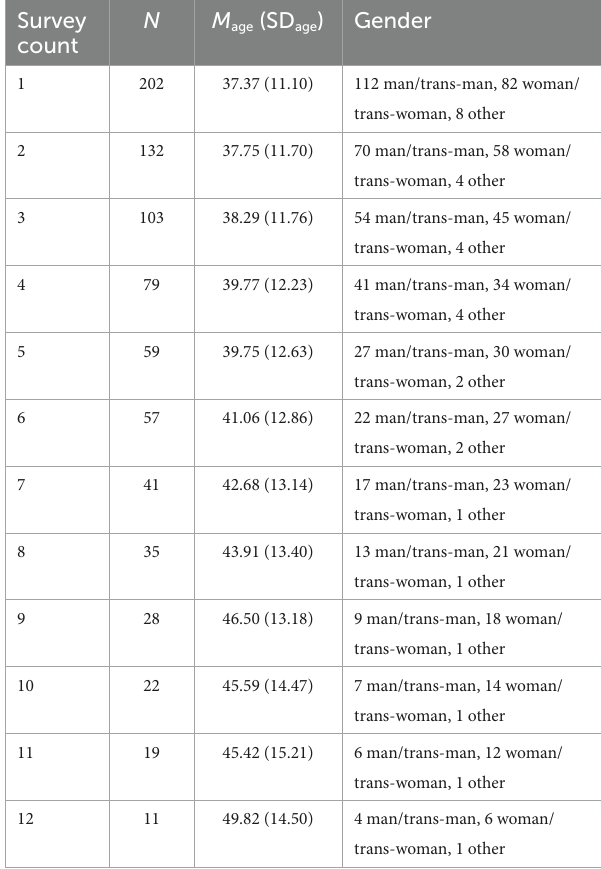
TABLE 1B Demographic data for participants who completed each number of